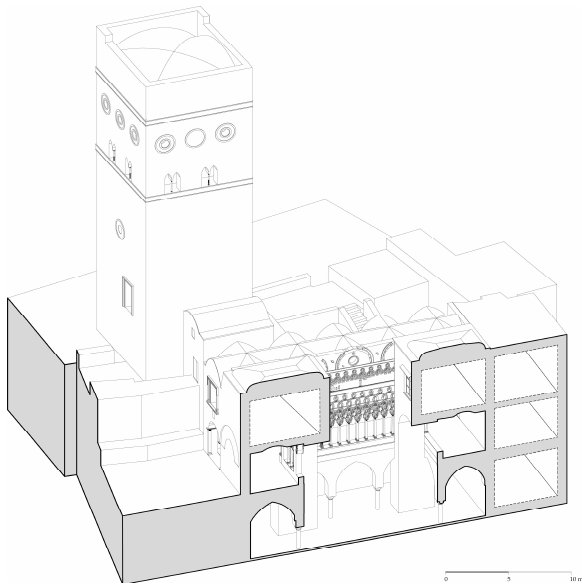
Figure 7. Axonometric section from digital model Phase VI: representations of two-and three-dimensional, 3D modeling. This phase covers all operations return and use the data acquired during the survey. It is important to acquire the three-dimensional models as well as various render, whereas only models allow further manipulation is both metric checks.